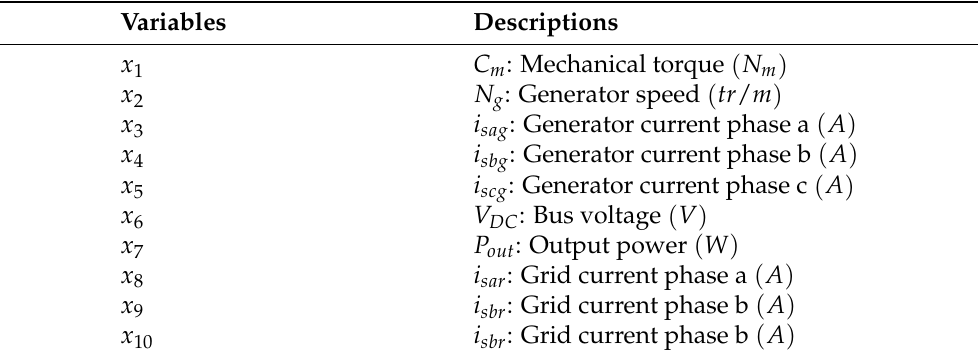
Table 4. Labeling and description of the measured and monitored system variables.